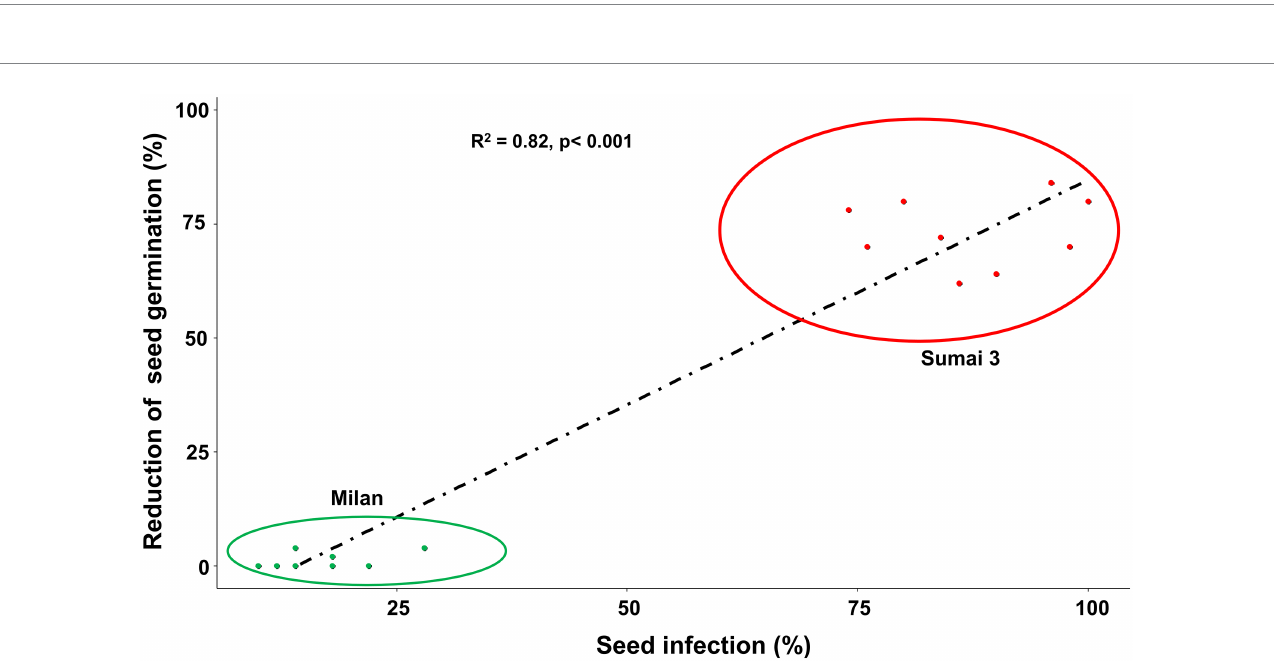
FIGURE 3 Relationship between MoT seed infection (%) and reduction of seed germination (%) of Sumai 3 (red) and Milan (green). Spearman Rank correlation analysis was performed to visualize the correlation data.